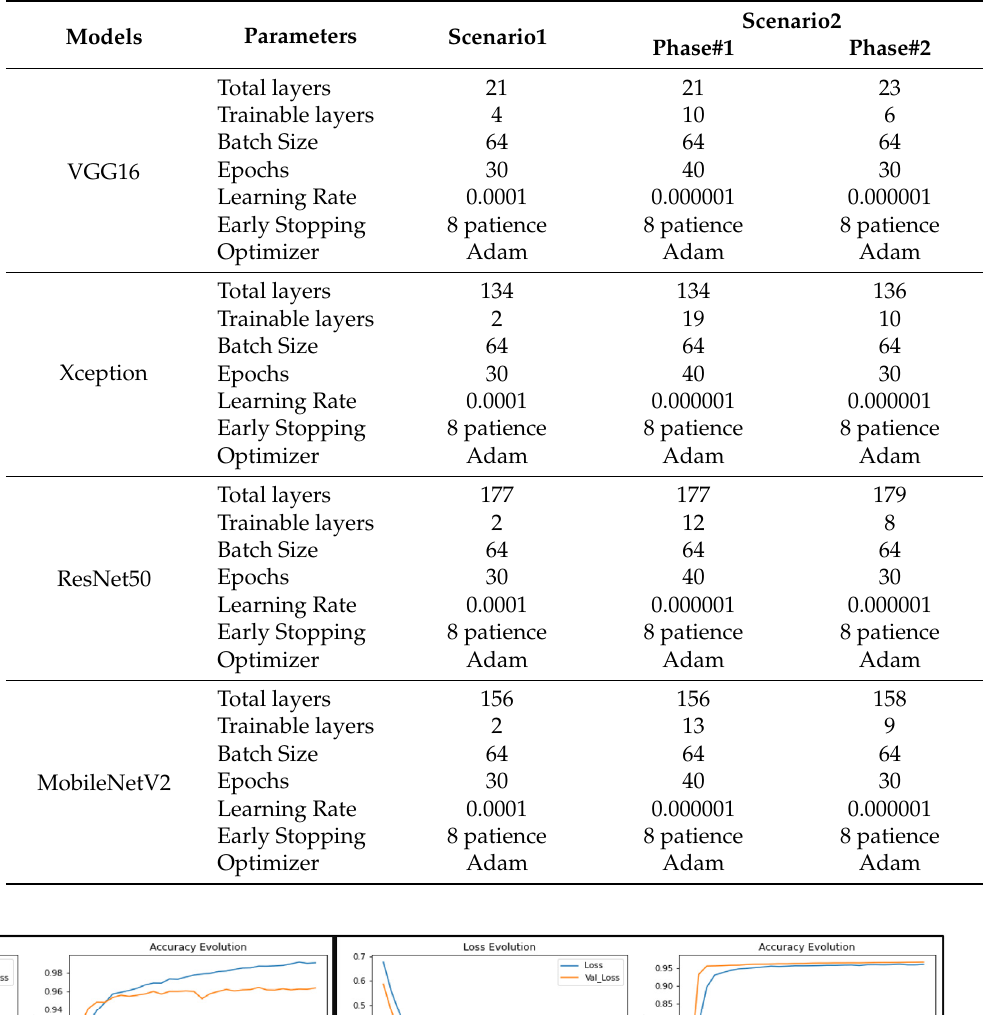
Table 5. Hyperparameters selection for Scenario1 and Scenario2.